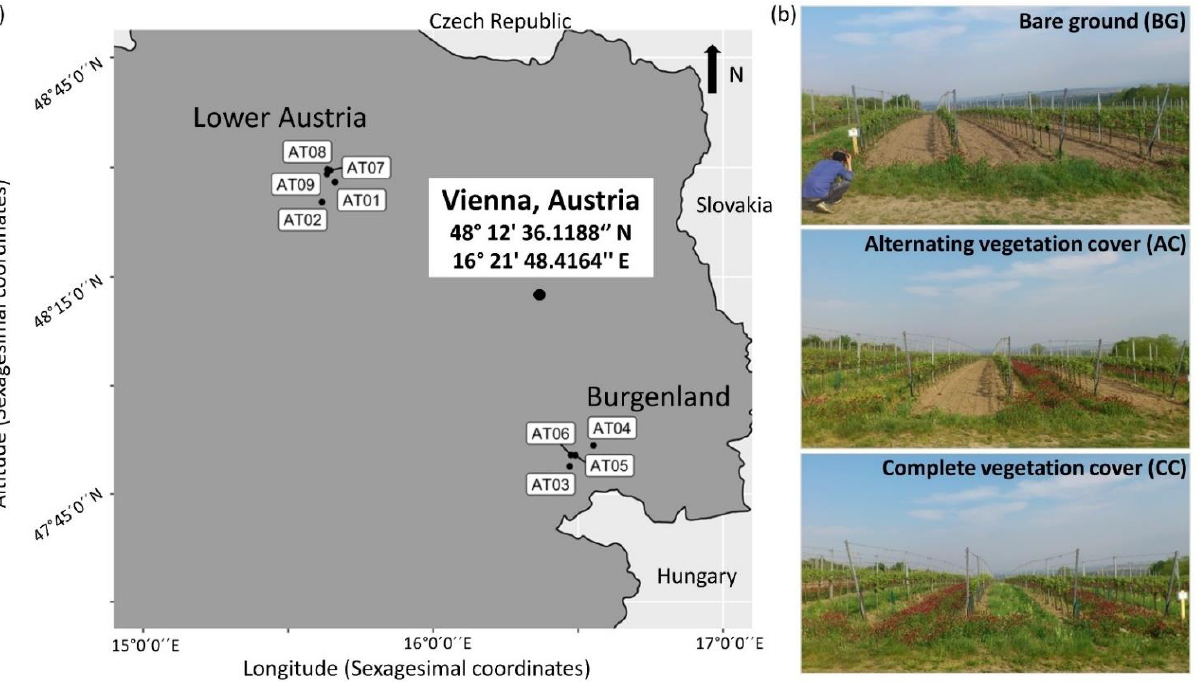
Figure 1. Location of the nine commercial vineyards in two viticulture regions in Austria, Lower Austria vineyards AT01, AT02, AT07–AT09 and Burgenland vineyards AT03–AT06 ( a ) and repre- sentative pictures of the different ground cover treatments established in each of the vineyard sites ( b ). Treatments: bare ground by tillage (BG), alternating vegetation coverage (AC) and complete vegetation coverage (CC).